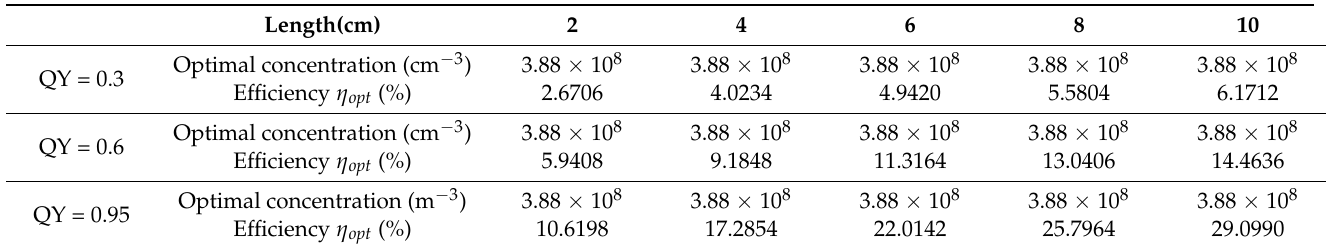
Table 4. Optimal efficiencies for different lengths and optimal concentrations in a radius of 5 cm and quantum yields of 0.3, 0.6, and 0.95.